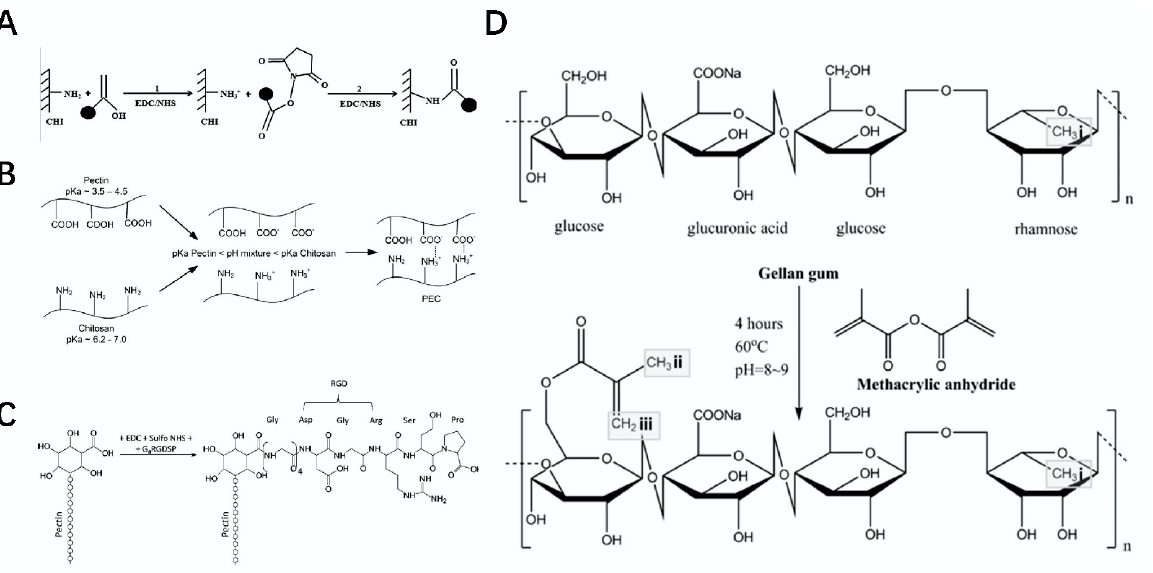
Figure 4. Synthesis roadmap of polysaccharide composites. ( A ) schematic diagram of the prepara- tion of chitosan scaffold modified by heparin [60]. ( B ) schematic diagram of the preparation of the PEC composite scaffold [61]. ( C ) schematic diagram of the preparation of pectin materials [17]. ( D ) schematic diagram of hydrogel modified by methacrylate [62].